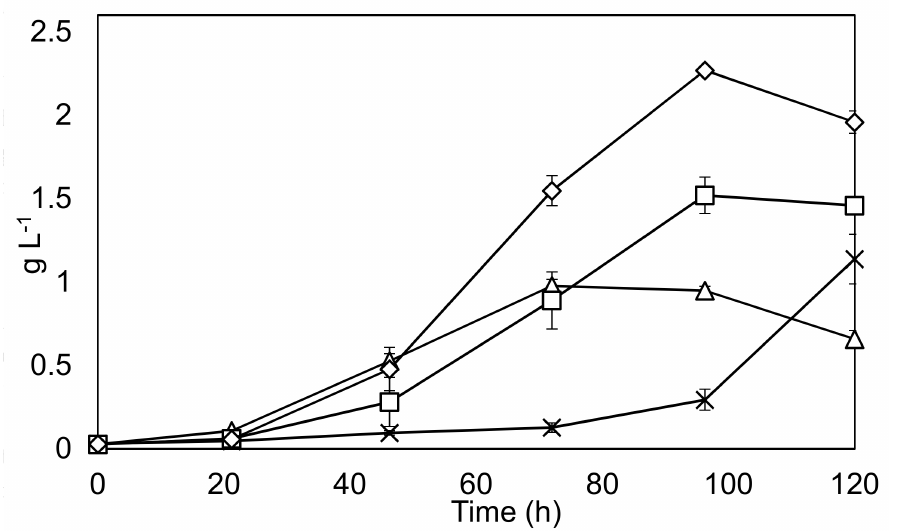
Figure 5. Optimization of feeding strategy. Solid black lines represent biomass dry weight on y-axis. Triangles: 1 × BBM, Squares: 3 × BBM, Diamonds: 3 × BBM fed batch, Crosses 10 × BBM. Experiments were undertaken in triplicate, and the error bars show 2 standard deviations from the